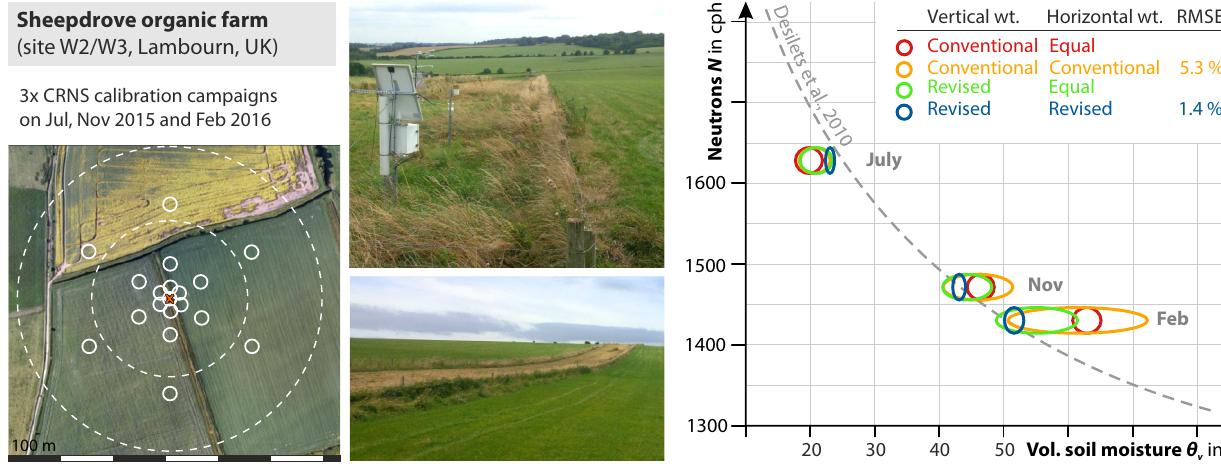
Figure 5. Recalibration of the CRNS sensor in the Sheepdrove Organic Farm (Lambourn, UK) using different combinations of vertically and horizontally weighted averages. Sizes of the circles indicate the corresponding uncertainty range of the measurement. The revised approach clearly removes the bias by the exceptional strip around the sensor, improving the calibration performance with regards to the widely accepted theoretical relation (dashed).